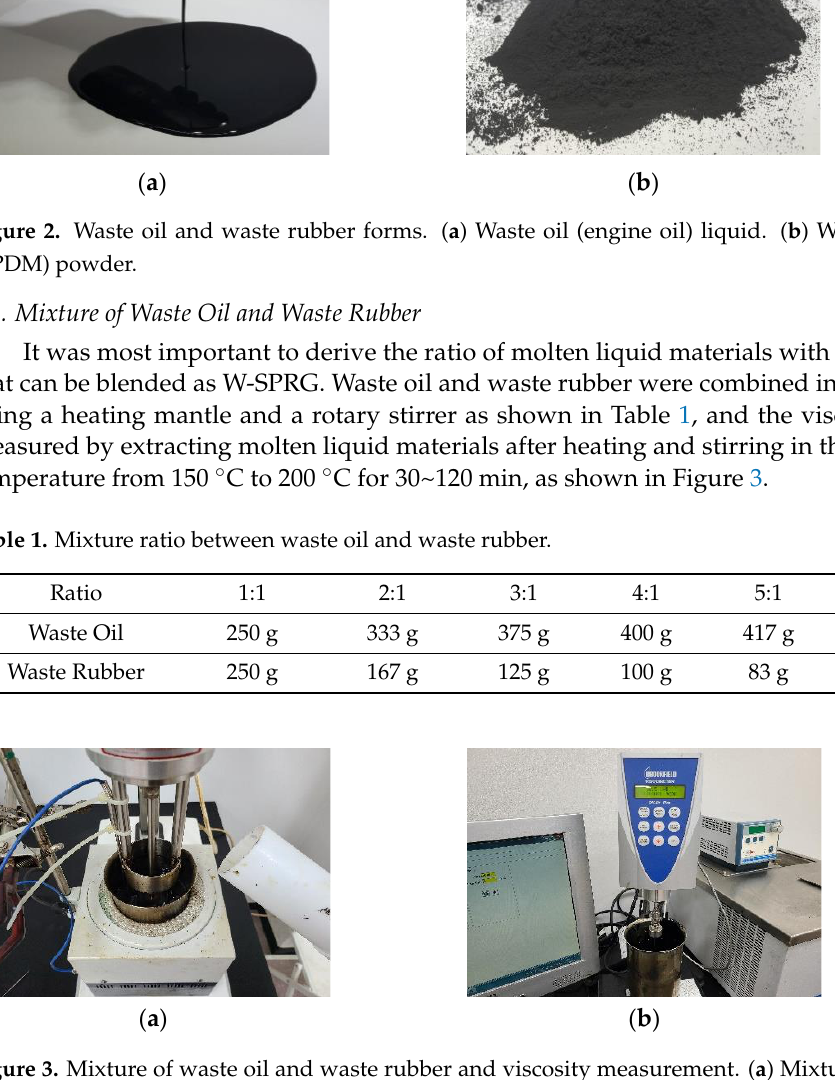
Table 2. Other components and range of W-SPRG.